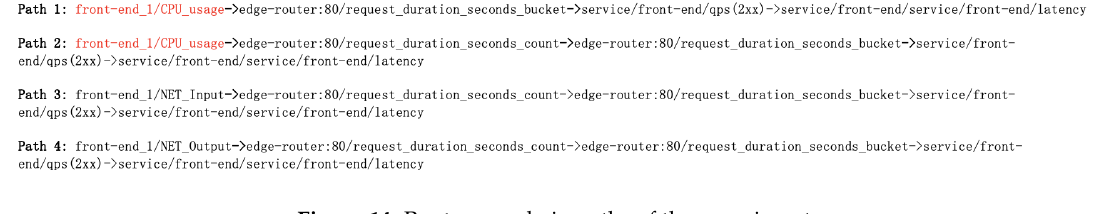
Figure 14. Root cause chain paths of the experiment.